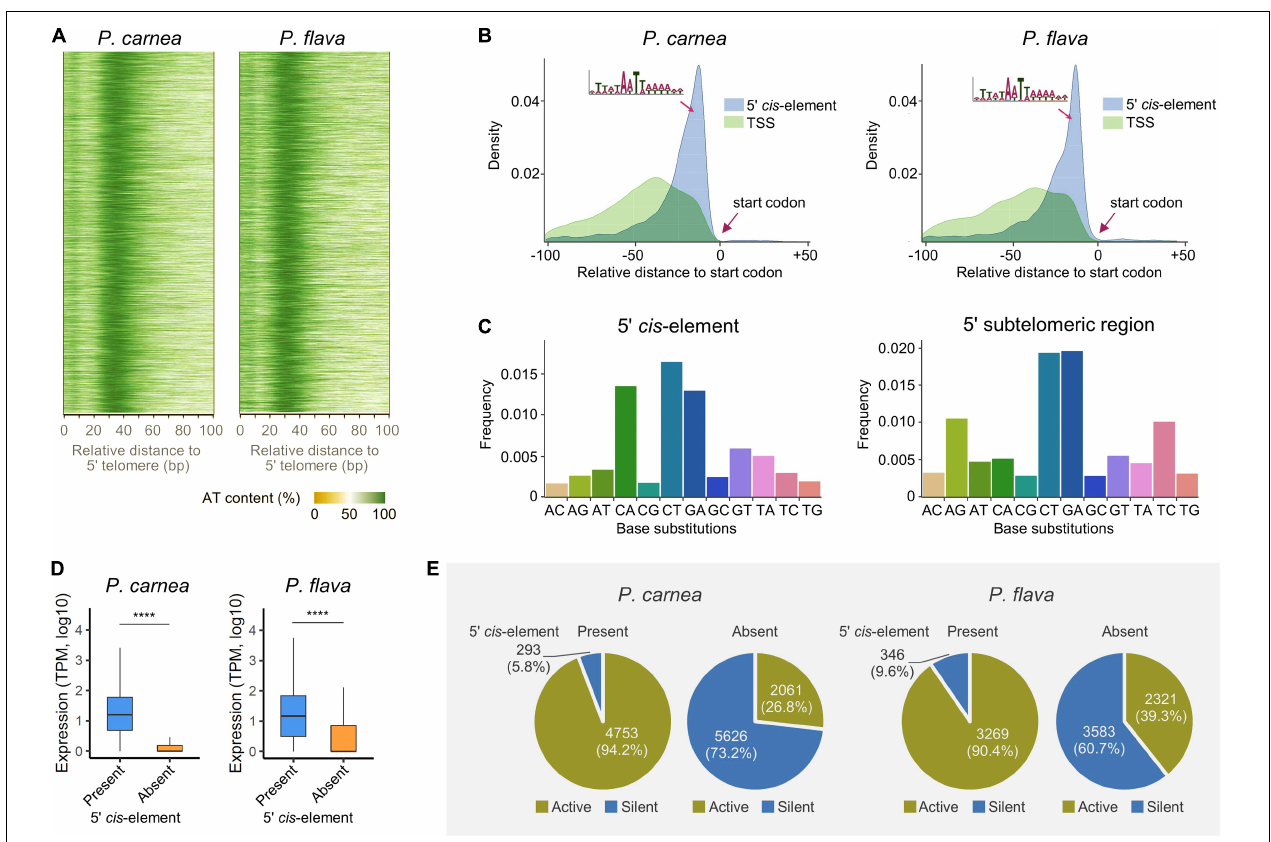
FIGURE 3 | A conserved potential cis -regulatory element (CRE) in 5 (cid:48) subtelomeric region on the nanochromosome. (A) Heatmap showing the AT content in the sequences of 5 (cid:48) subtelomeric regions of Pseudokeronopsis carnea (left) and P. flava (right). (B) Density plot showing the intermediate position of the CRE in an AT-rich motif between transcription start site (TSS) and translation start codon. (C) Frequency of base substitutions in 5 (cid:48) CRE and entire subtelomeric region in P. flava . “AC” indicates nucleotide substitutions where adenine is replaced by cytosine, for example. (D) The presence of the putative 5 (cid:48) CRE is associated with the transcription level of its adjacent genes. TPM, transcripts per million. **** p < 0.0001. (E) Pie plots showing the percentage of active and silent genes correlated with the presence or absence of the putative 5 (cid:48) CRE on nanochromosomes.